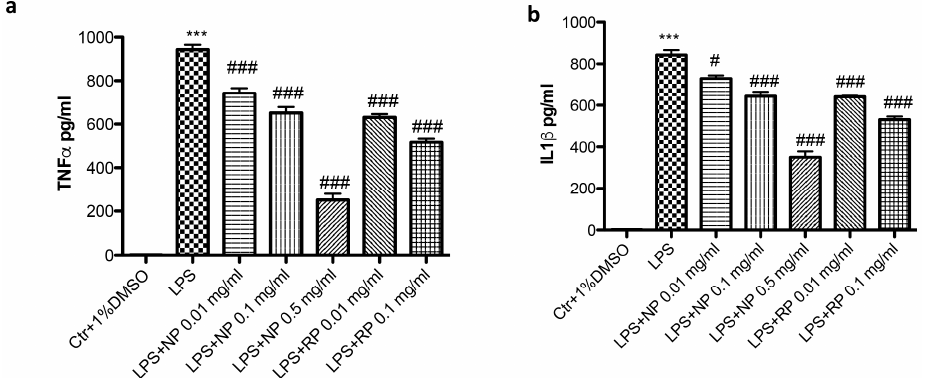
Figure 3. Effect of NP and RP of pro ‐ inflammatory cytokines production. LPS stimulation significantly increased the levels of: TNF ‐α ( a ); and IL ‐ 1 β ( b ). Treatments with NP and RP decreased the levels of: TNF ‐α ( a ); and IL ‐ 1 β ( b ) in a concentration dependent manner. *** p < 0.001 vs. Ctr; ### p < 0.001 vs. LPS; # p < 0.05 vs. LPS.